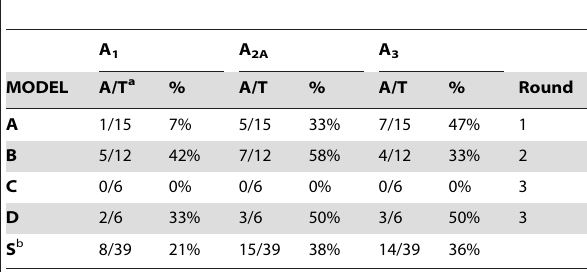
fragments were scored with DOPE and DOPE_HR (DOPE high resolution) and the top five scoring models were inspected visually. Criteria in this visual inspection were the absence of obvious steric clashes with 1 , the absence of kinks in the helices, an orientation of the sidechain of Asn254 6.55 away from the main chain, and preservation of the disulfide bonds between Cys80 3.25 -Cys169 and Cys260 6.61 -Cys263 7.28 (superscripts denote Ballesteros-Weinstein numbers [19]). The model that was chosen among the top five according to these criteria was denoted as model O . Table 2. Performance of the four homology models against the three AR